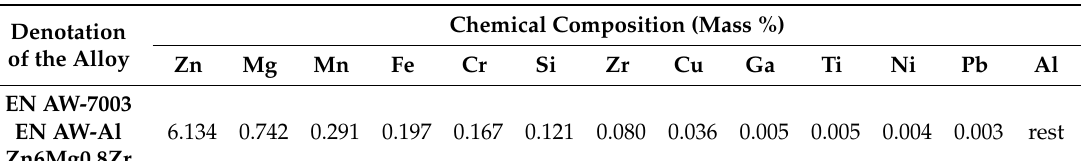
Table 1. Chemical compositions of the investigated